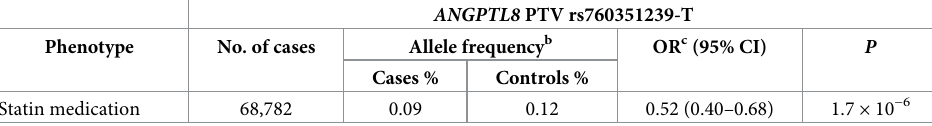
Table 4. Phenome-wide associations with the ANGPTL8 protein-truncating variant in the FinnGen Study.